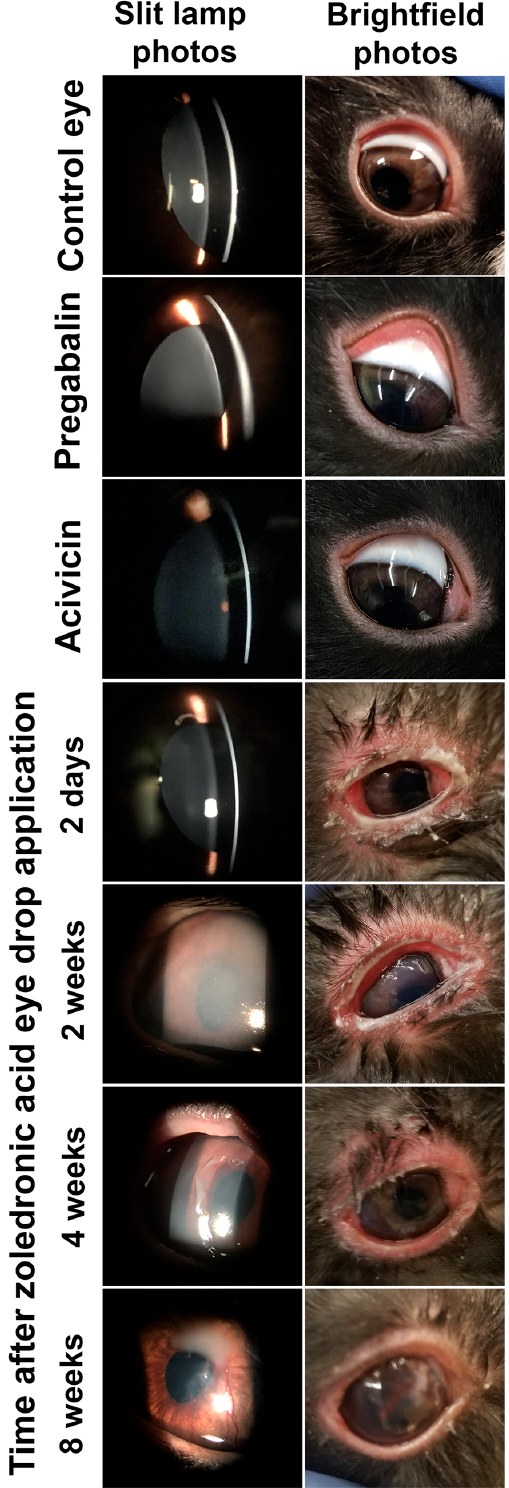
Figure 5. In vivo safety evaluation of eye drops containing different molecules after a single topical application. Zoledronic acid eye drop caused eye reactions up to eight weeks after application. Control eyes refer to the contralateral eye of rabbits that received zoledronic acid eye drops. Photos of the control eyes and those dosed with pregabalin and acivicin were taken 2 days after topical application of a single eye drop of the corresponding formulation.